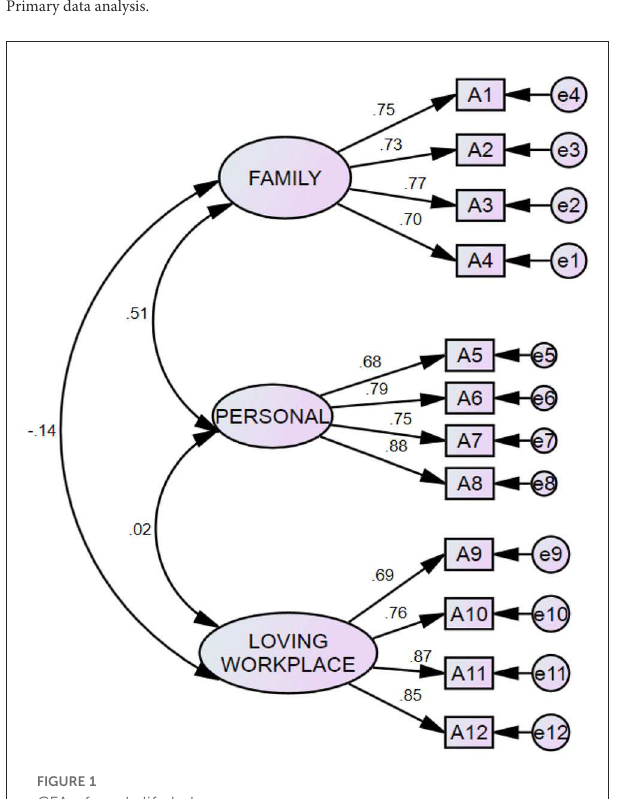
required every idle variable to have four or more pointers (things). Direction estimations and their statistical significance, in